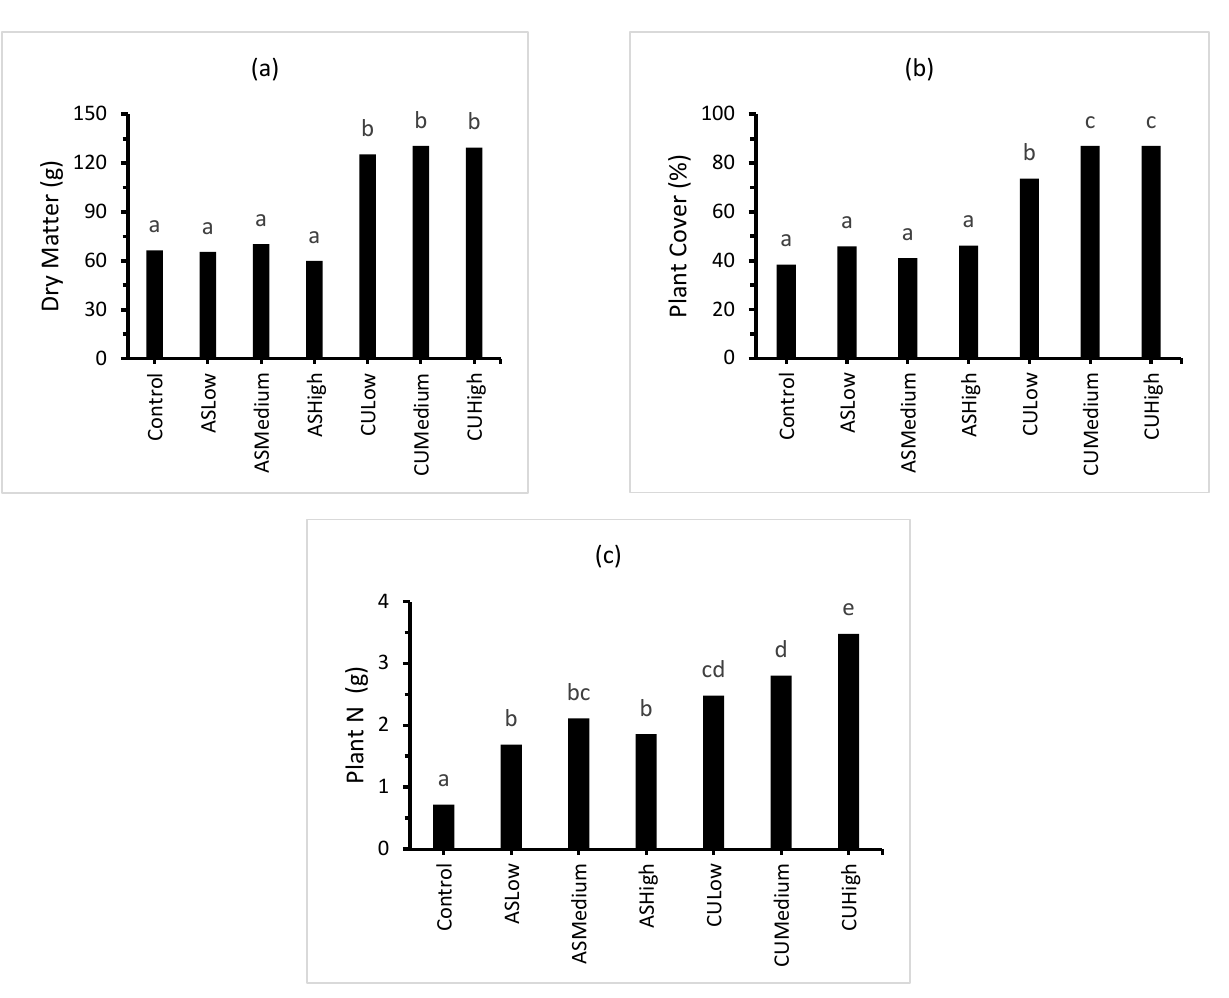
4 ) 2 SO 4 (ASLow, ASMedium and ASHigh) contained signif-